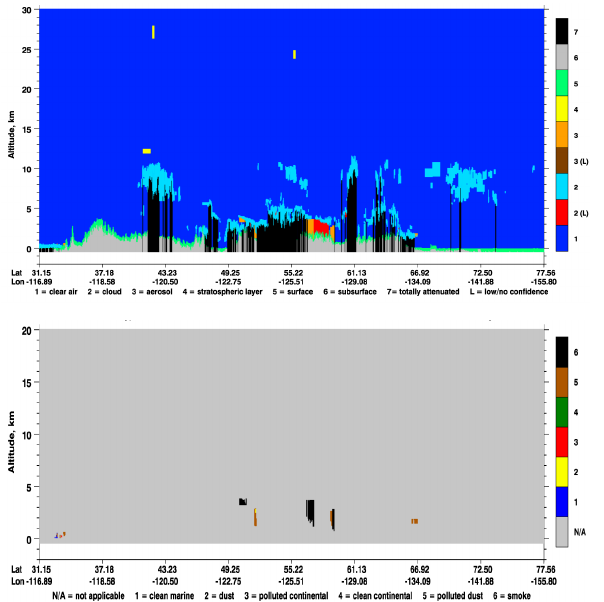
Fig. 15. CALIPSO vertical feature mask (top) and aerosol subtype (bottom) plots near CORALNet Egbert on 27 June at approx- imately 08:13UTC (http://www-calipso.larc.nasa.gov/products/ lidar/browse images/show date.php?s=production \ &v=V3-01 \ &browse date=2011-06-27).